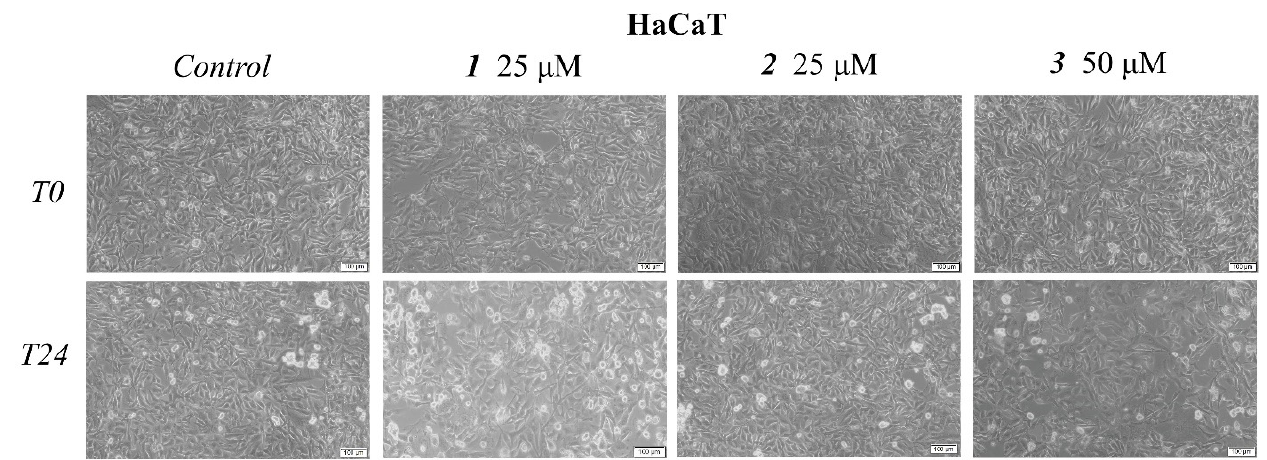
Figure 3. Representative images of the morphological aspects of HaCaT cells after treatment for 24 h with 1 , 2 (25 μ M), and 3 (50 μ M). The scale bar was 100 μ m.